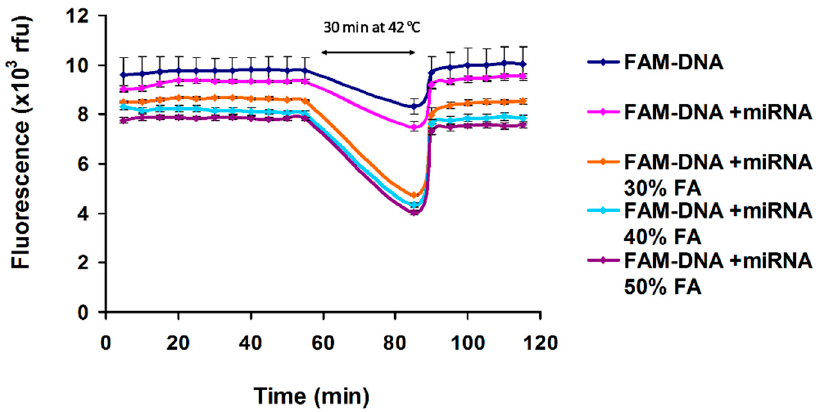
Figure 2. Effect of formamide on FAM-DNA/microRNA (18nt) hybridization. The detection is based on hybridization quenching due to photoinduced electron transfer (PET). The experiments were done in triplicate samples. Error bars represent the standard deviations of triplicate values.